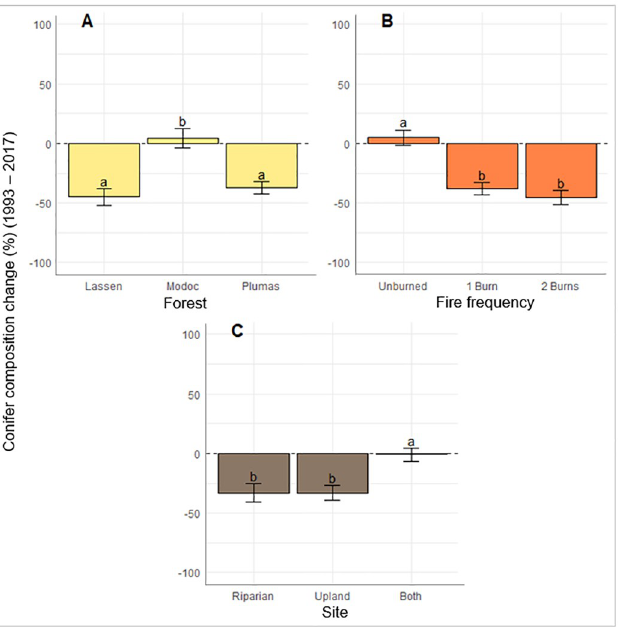
Fig 10. Conifer composition change between 1993 and 2017: A) differences among forest, B) fire frequencies and C) site types, e.g. if a stand’s conifer composition was 50% in 1993 and 10% in 2017, it’s conifer composition change was -40%. Graphed values are from pairwise comparisons acquired with emmeans. Error bars represent standard error. Categories with same letter were not significantly different.